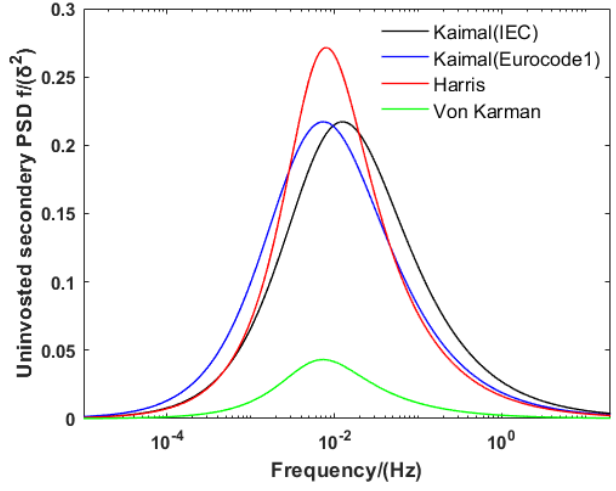
Figure 1. The longitudinal dimensionless velocity of the wind power density spectrum curve.